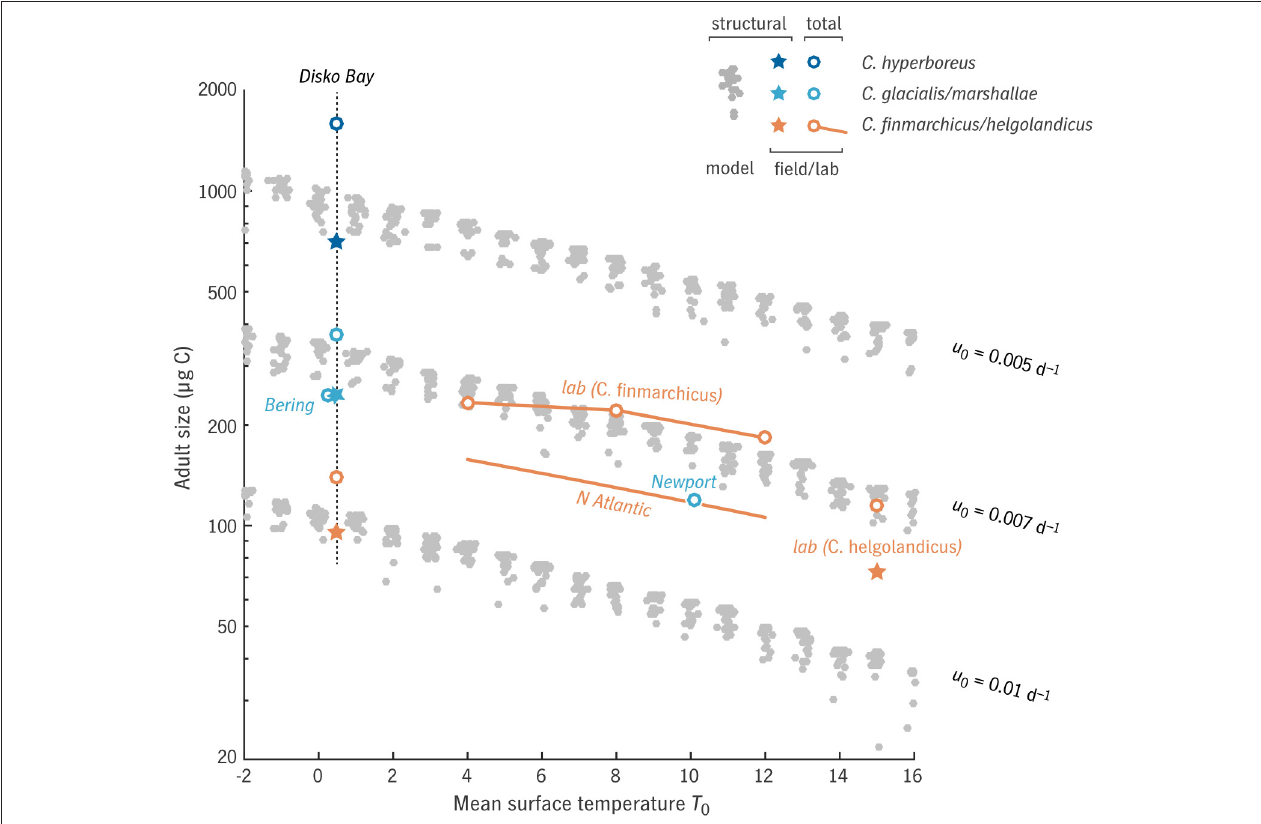
FIGURE 4 | Relationship between adult size W a and mean surface temperature T 0 in the “global” model experiment, for three values of relative development rate u 0 , in comparison with observations ( Peterson, 1986; Swalethorp et al., 2011; Wilson et al., 2015; Campbell et al., in press) and laboratory results (Campbell et al., 2001; Rey-Rassat et al., 2002). Model results (gray dots) represent structural biomass S , as do observations marked with a ⋆ ; observations marked with a ◦ represent total biomass R + S . Clusters of gray dots indicate families of model cases varying productive season length (horizontal axis in Figure 5